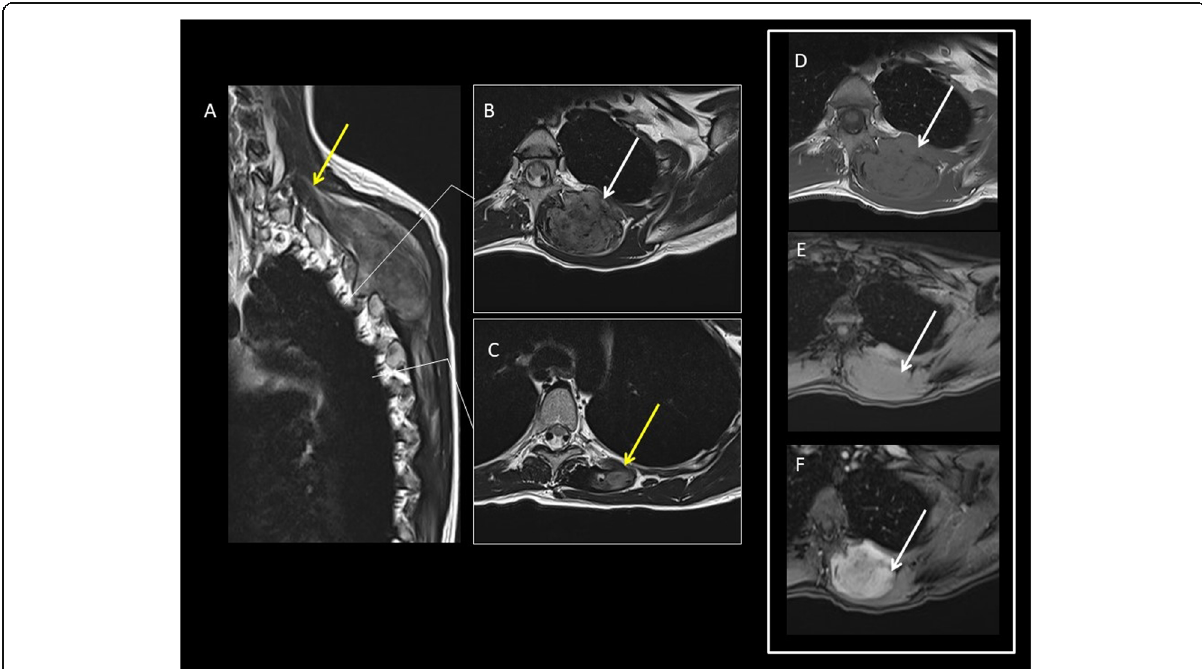
Fig. 2 A 24-year-old female patient with DT located superficially into the left paravertebral muscle with infiltration of intercostal space. MR T2wi (sagittal ( a ) and axial plane ( b , c )) showed a soft tissue mass with a heterogeneous hyperintense signal with band-like low-signal intensity ( “ band sign ” ). The lesion was isodense to the adjacent muscle on T1 ( d ) and fat sat T1 ( e ) and showed homogenous and late contrast enhancement. Especially, the sagittal plane ( a ) shows lesion extension along the fascial plane (yellow arrow, also in c )